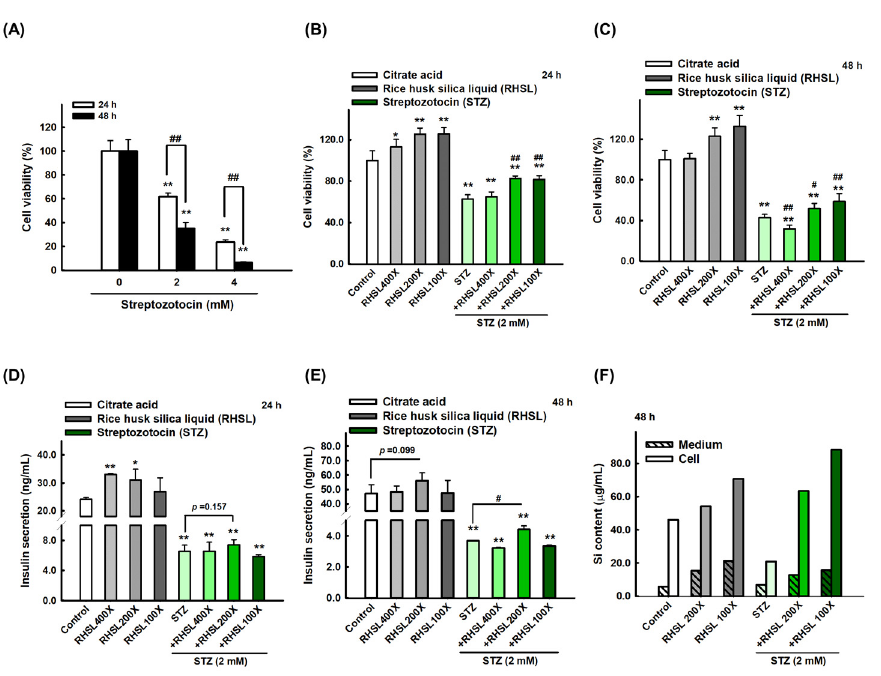
Figure 1. Rice husk silica liquid (RHSL) reverses streptozotocin (STZ)- induced cell viability and insulin secretion in RIN-m5F cells. ( A ) Screen the dosage of STZ (2 and 4 mM) for cell viability at 24 and 48 h. ( B , C ) The effect of RHSL and STZ treatment on cell viability for 24 and 48 h. ( D , E ) The amount of insulin (ng/mL) at 2 mM of STZ when treated with different dilutions of RHSL (400×, 200×, and 100×). ( F ) The level of silicon in cell pellet or culture medium at 2 mM of STZ when treated with different dilutions of RHSL (400×, 200×, and 100×). * p < 0.05; ** p < 0.001 compare with each control group (citrate acid). # p < 0.05; ## p < 0.001 compare with STZ group.